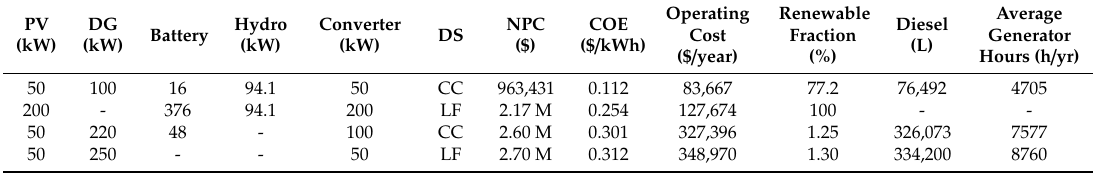
Table 2. Categorized optimization results summary of the system configurations.